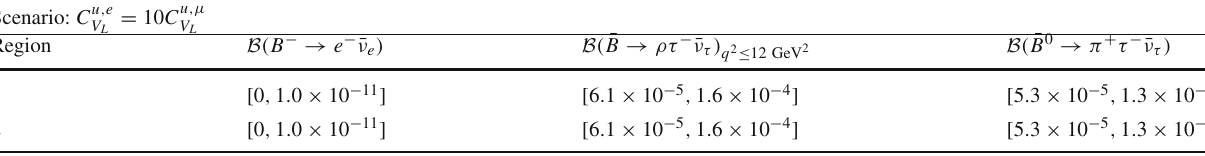
Table 4 Predictions for branching ratios that have not yet been measured in the scenario where NP enters through new contributions to the left-handed vector coefficient, making the assumption that C u , e